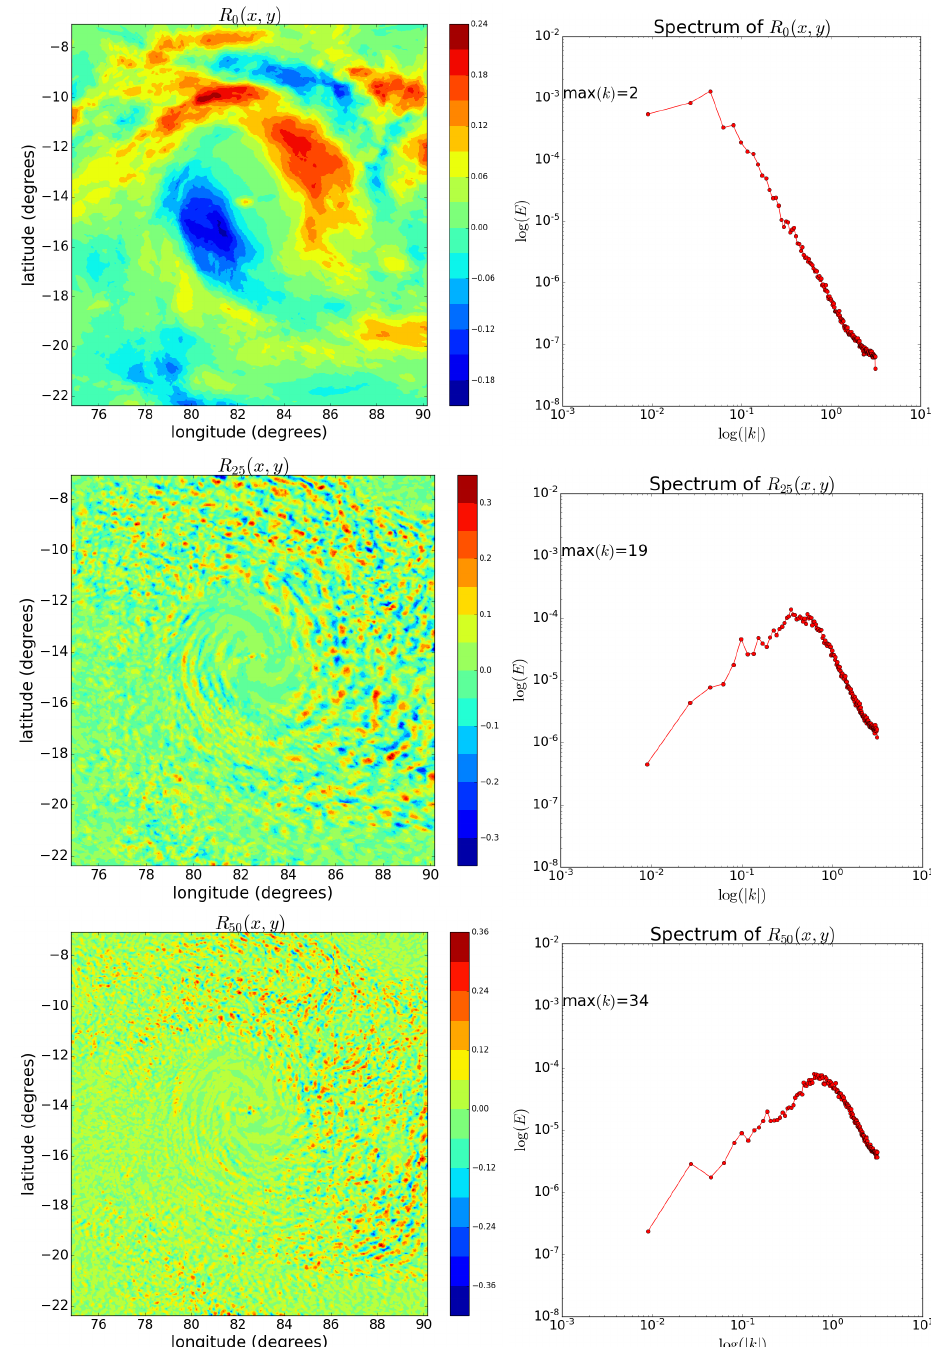
Figure 4. Left panels, from top to bottom: contour plots, as functions of longitude and latitude, for the eigenfunctions order j = 0, j = 25 and j = 50 (corresponding to macro-, meso-, and small-scales) for the Faraji cyclone. Right panels, from top to bottom: shell-integrated Fourier spectra in double logarithmic scales of the same eigenfunctions. The peak of the spectra is continuously shifted towards larger wave vectors (smaller scales) as the order of the eigenfunction j